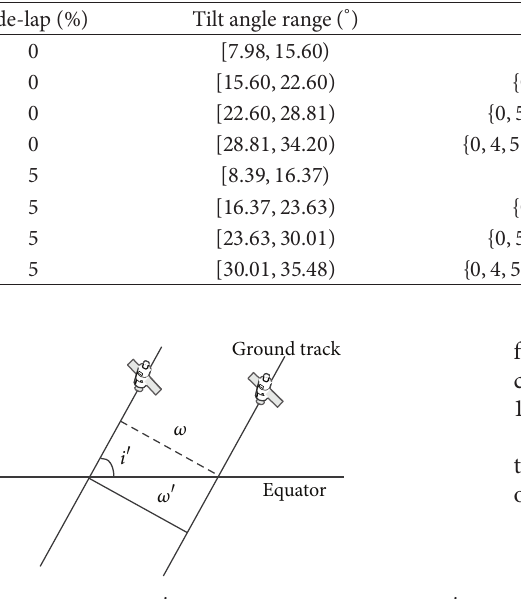
Figure 5: Apparent inclination 𝑖 󸀠 and the swath on the equator 𝜔 󸀠